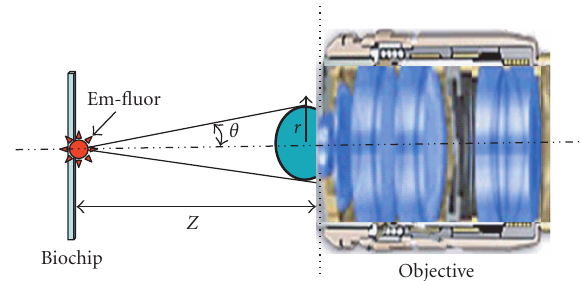
Figure 2: The configuration of the objective collecting